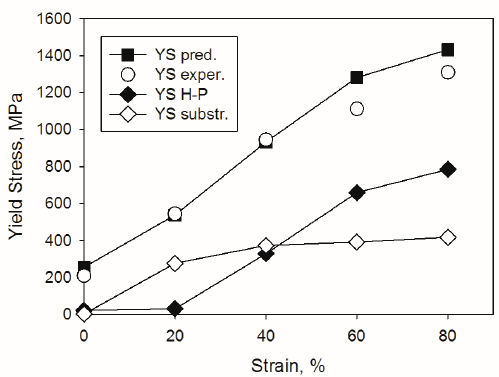
Figure 7. Contribution of different strengthening mechanisms to the overall strength of the Al-, C-containing CoCrFeNiMn-type alloy during rolling.